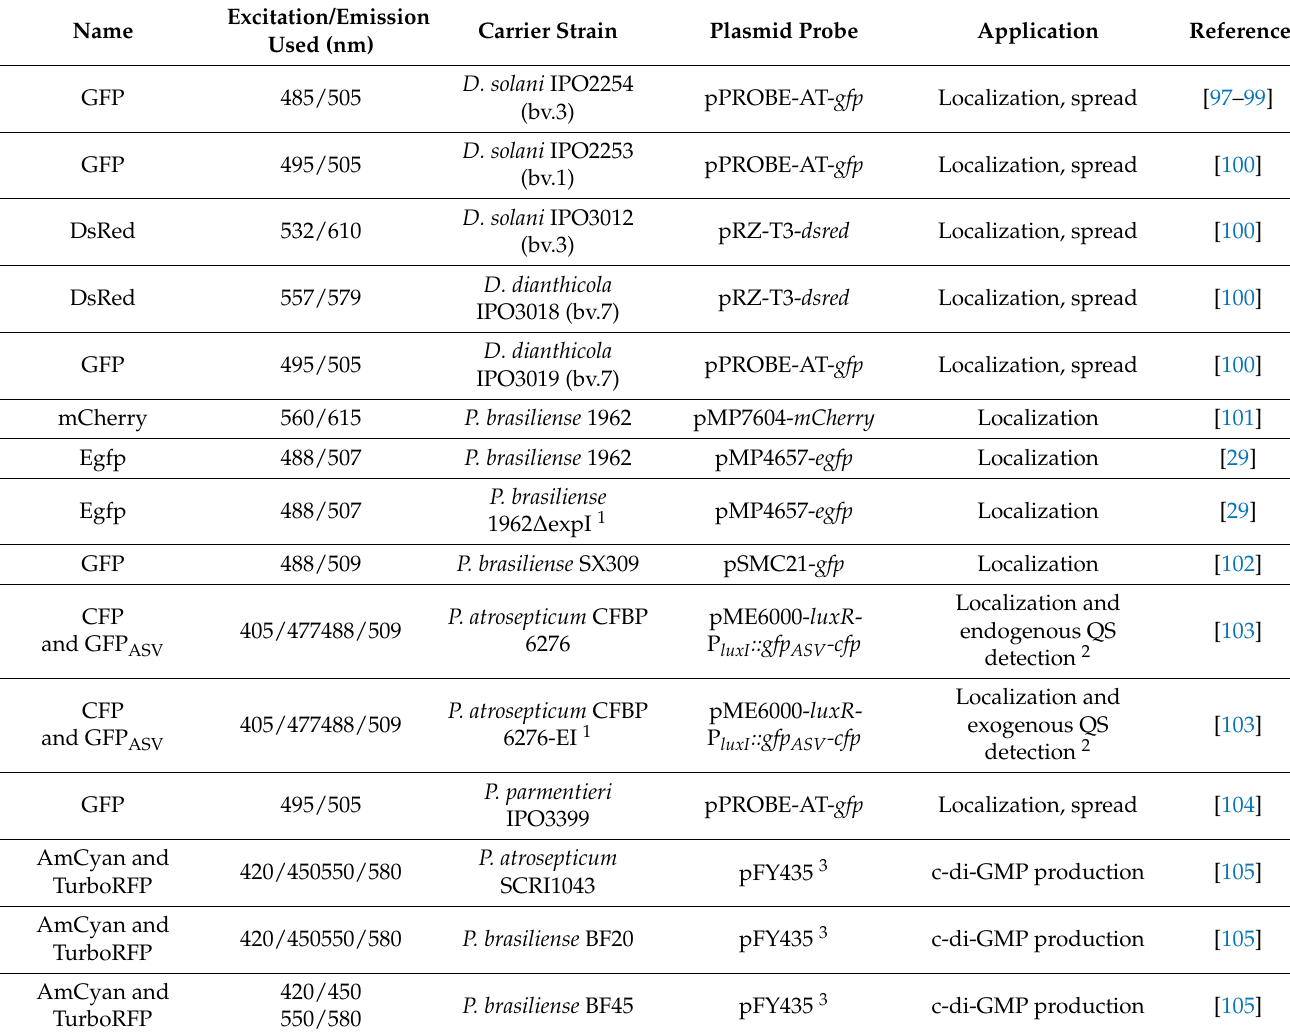
Table 1. Fluorescent proteins already used to construct Dickeya and Pectobacterium tagged strains and